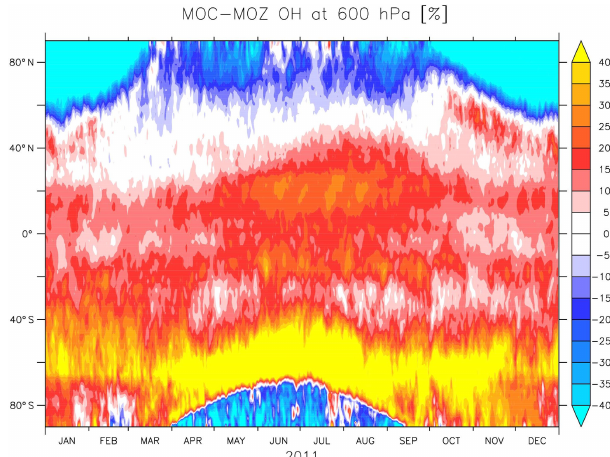
Figure 4. Relative differences (in percent) of OH daily averaged mixing ratios of simulation MOC with respect to MOZ at